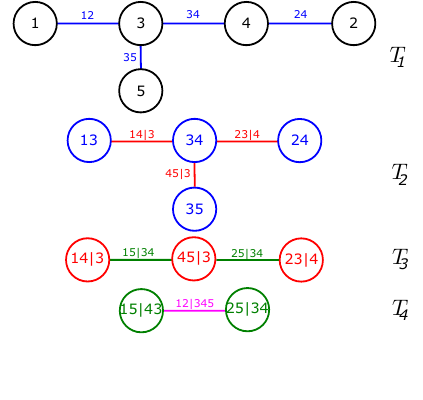
Figure 8: R-vine structure for d = 5